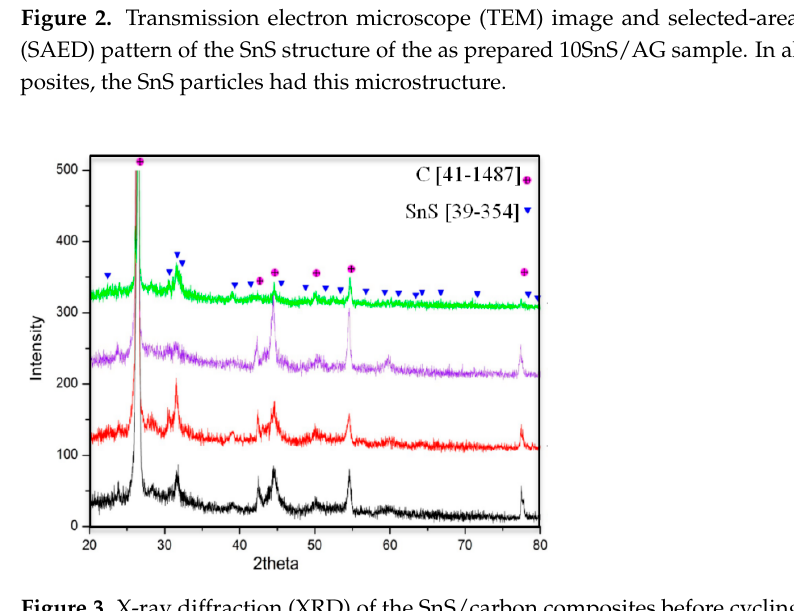
Figure 3. X-ray diffraction (XRD) of the SnS/carbon composites before cycling. Green : 20SnS/AG, purple : 20SnS/AG, red : 20SnS/MCMB, black : 10SnS/MCMB.